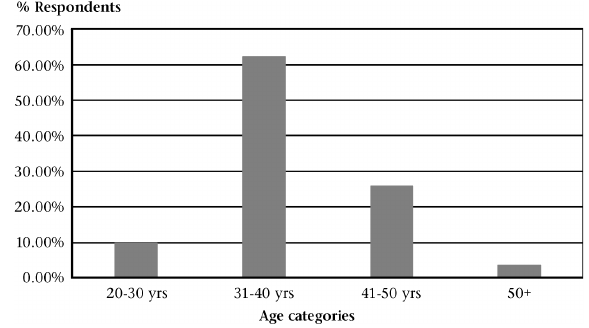
Figure 1: Age Analysis of Sample